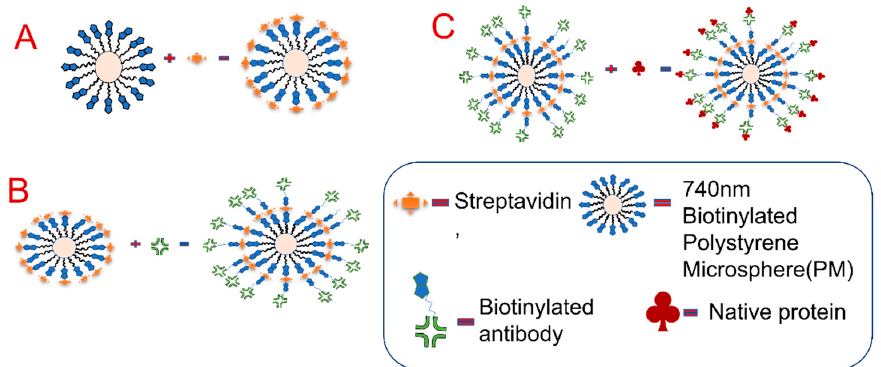
Figure 2. Schematic representation of the sample preparation (Biotinylated polystyrene microspheres (PM) + Streptavidin + Biotinylated CA 242/CEA Monoclonal Antibody) with the antigen Native Protein CA 242/CEA, assuming binding in all of the available sites of the antibody. ( A ) Binding of biotinylated PM with streptavidin. ( B ) Functionalization of the PM with antibodies. ( C ) Assay for the detection of the antigens.